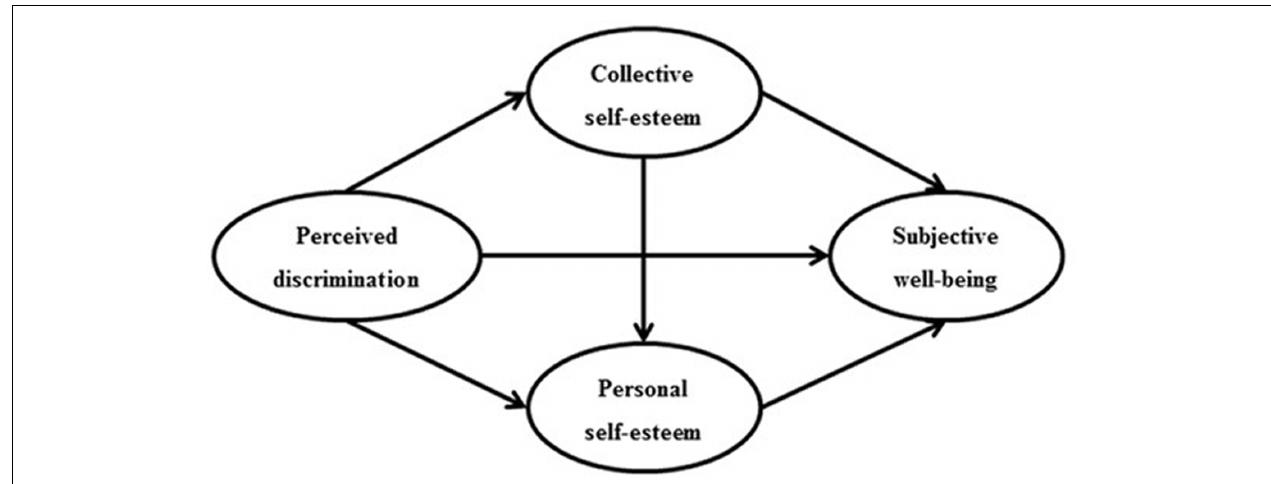
FIGURE 1 | Hypothesized model. Unidirectional arrows indicate the path of one variable on